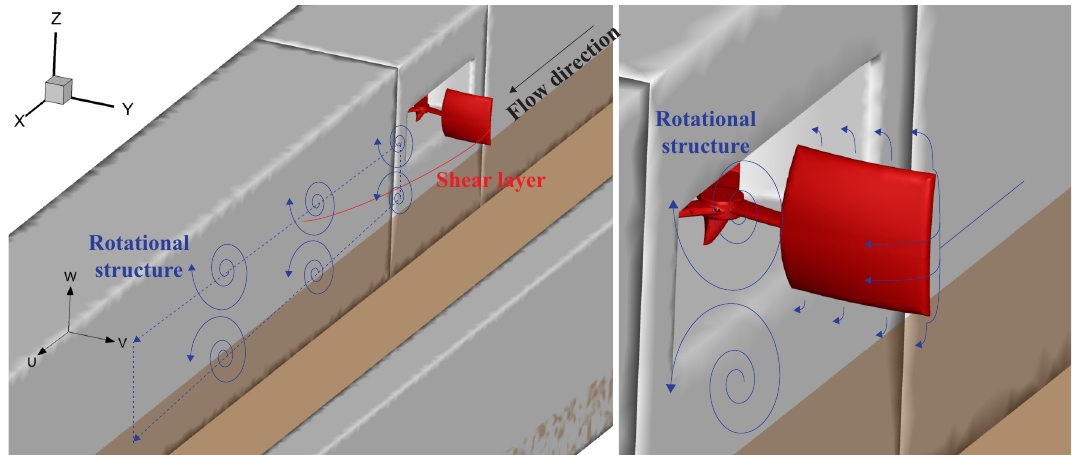
Figure 7. Schematic view of 3D flow structure observed in the wake of the turbine.